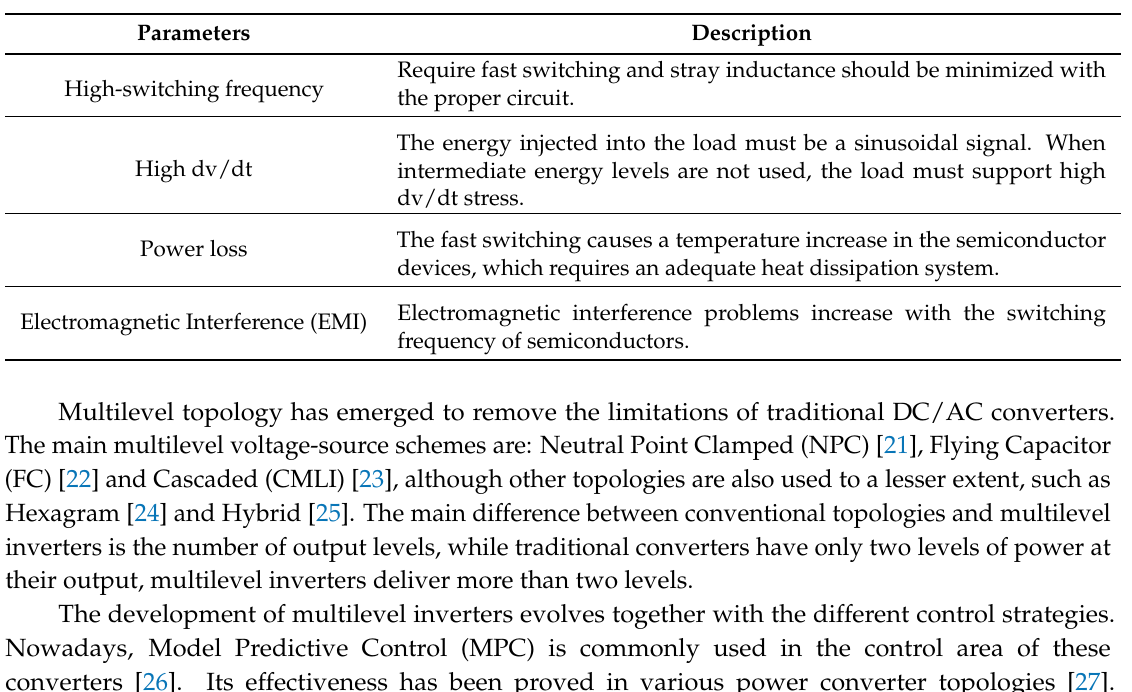
Table 1. Main conventional inverters